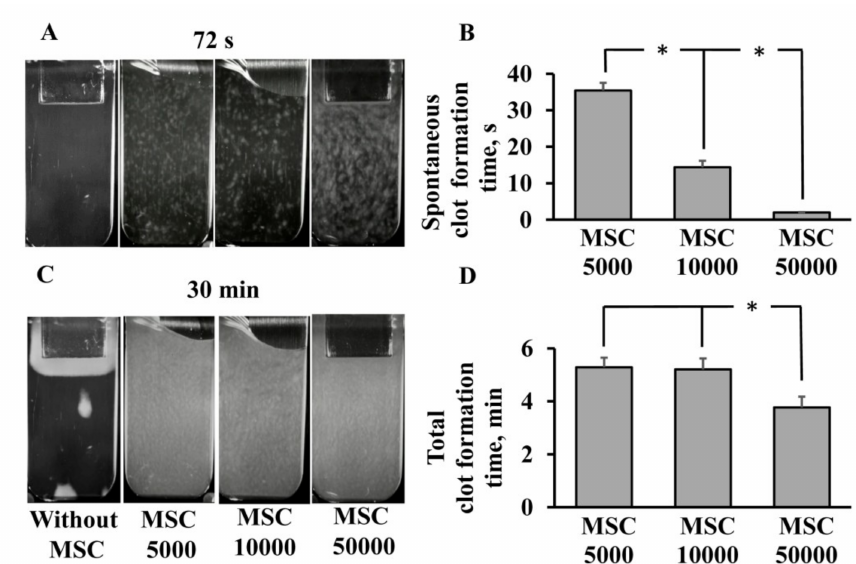
Figure 2. Dose-dependent effect of MSCs on clotting induction in human platelet-free plasma (PFP) using a thrombodynamics test. ( A ) Representative screenshots (at 72 s) of thrombodynamics videos showing spontaneous clot appearance in PFP after the addition of different doses of MSC. ( B ) Spontaneous clot formation time. ( C ) Representative screenshots at the end of assay (30 min) showing the area occupied by a clot in a cuvette. ( D ) Total clot formation time in the full volume of the cuvette. MSC aliquots of 5 × 10 3 , 1 × 10 4 , and 5 × 10 4 cells and 10 µ L of PBS instead of cells (“Without MSC” sample) were resuspended in human PFP obtained from 1 mL of freshly collected blood, then 120 µ L of the mixture was sampled for analysis. Note, in the control PFP, spontaneous clot formation did not occur. Data reported as mean ± standard error of the mean (SEM) from at least